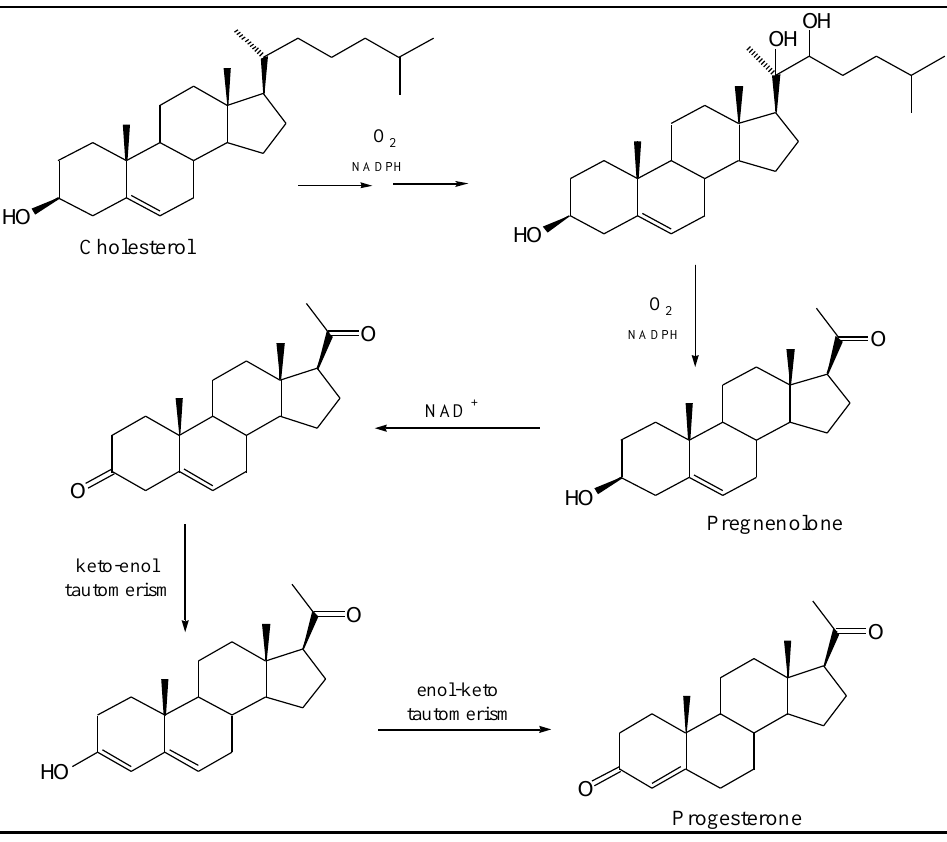
Figure (3) :conversion of cholesterol to progesterone